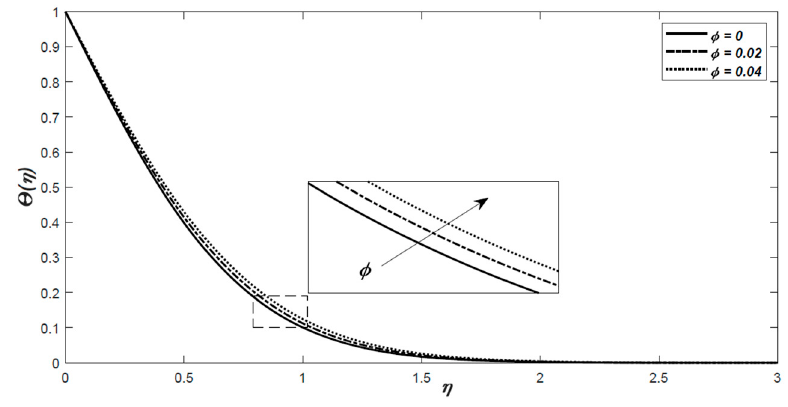
Figure 4. The variation of the dimensionless temperature profiles with 𝜙 for Al 2 O 3 –water with respect to similarity variable 𝜂 .